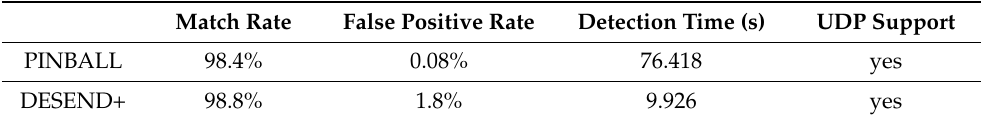
Table 12. Comparison between DESEND+ and PINBALL.